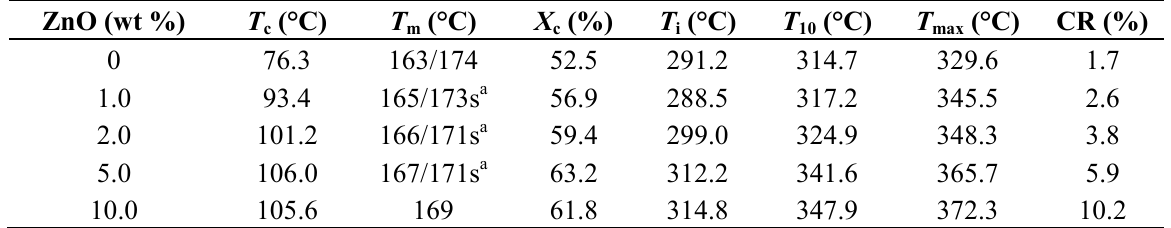
Table 1. Thermal parameters obtained from DSC and TGA analysis of PHB/ZnO nanocomposites . ZnO (wt